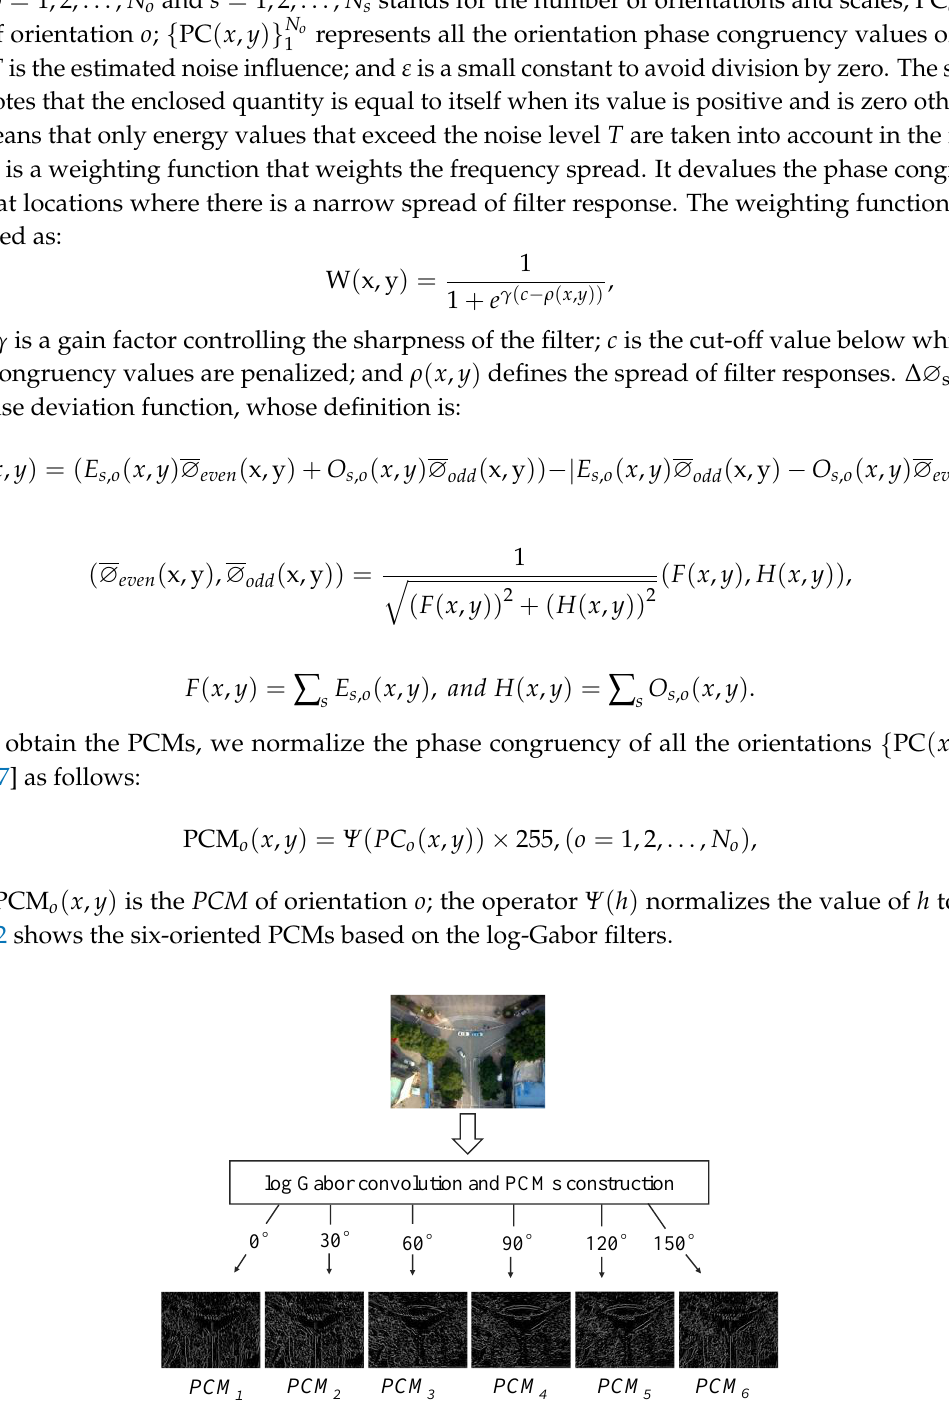
Figure 2. The calculated six-oriented PCMs based on the four-scale and six-oriented log-Gabor filters.